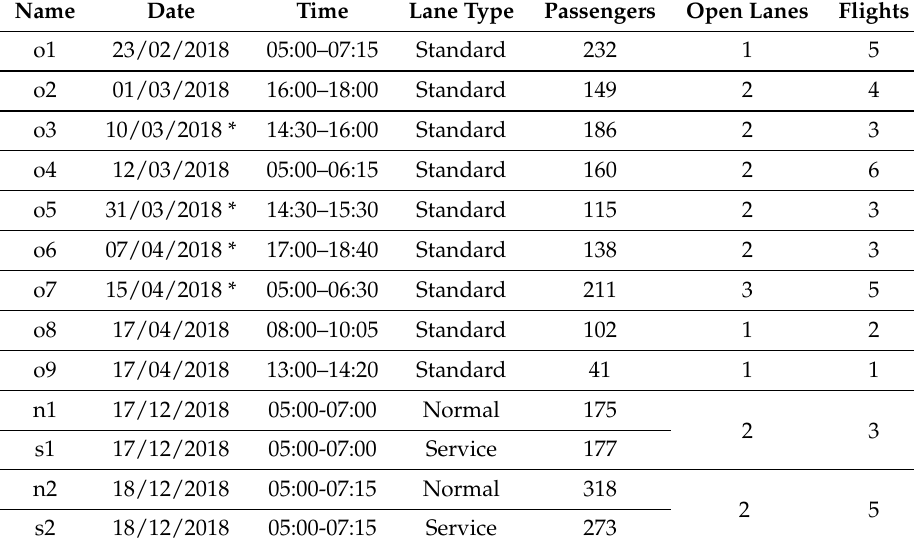
Table 1. An overview of the data that was collected. Passengers refers to the number of passengers that were observed in the lane, and open lanes is the number of security checkpoint lanes that were simultaneously open in the considered period. Flights is the total number of flights in the flight block immediately after the data collection time. Dates marked with * are either Saturday or Sunday (weekend days).